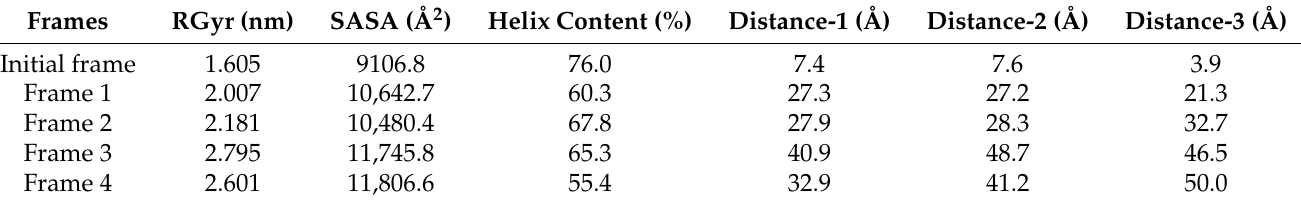
Table 2. Radius of gyration (RGyr), solvent-accessible surface area (SASA), helix content and distances between amino acid residues of the VSD of the initial frame and of each representative frame of each cluster. Distance-1: distance between GLU 87 and PHE 135. Distance-2: distance between TRP 122 and ALA 101. Distance-3: distance between GLU 87 and ARG 165.